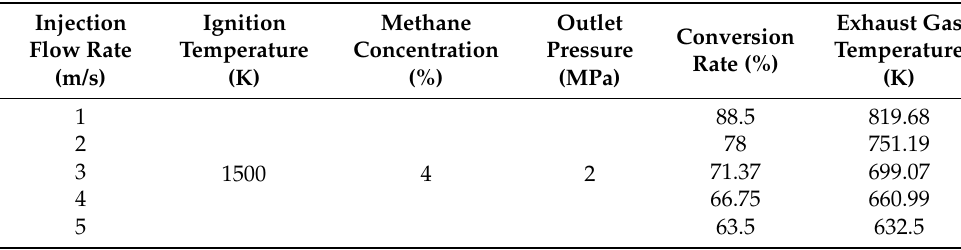
Table 7. Simulation parameters of the influence of injection rate on conversion rate and exhaust gas temperature at 2 MPa, 4% of CH 4 .